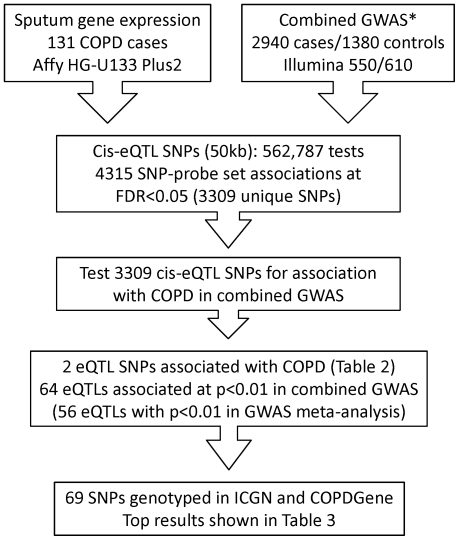
Overview of integrative genomics data analysis.*Combined genomewide association study (GWAS) = Evaluation of COPD Longitudinally to Identify Predictive Surrogate End-points (ECLIPSE), Bergen Norway, and National Emphysema Treatment Trial (NETT)-Normative Aging Study (NAS) [11]. COPD = chronic obstructive pulmonary disease. eQTL = expression quantitative trait locus. FDR = false discovery rate. ICGN = International COPD Genetics Network. SNP = single nucleotide polymorphism.